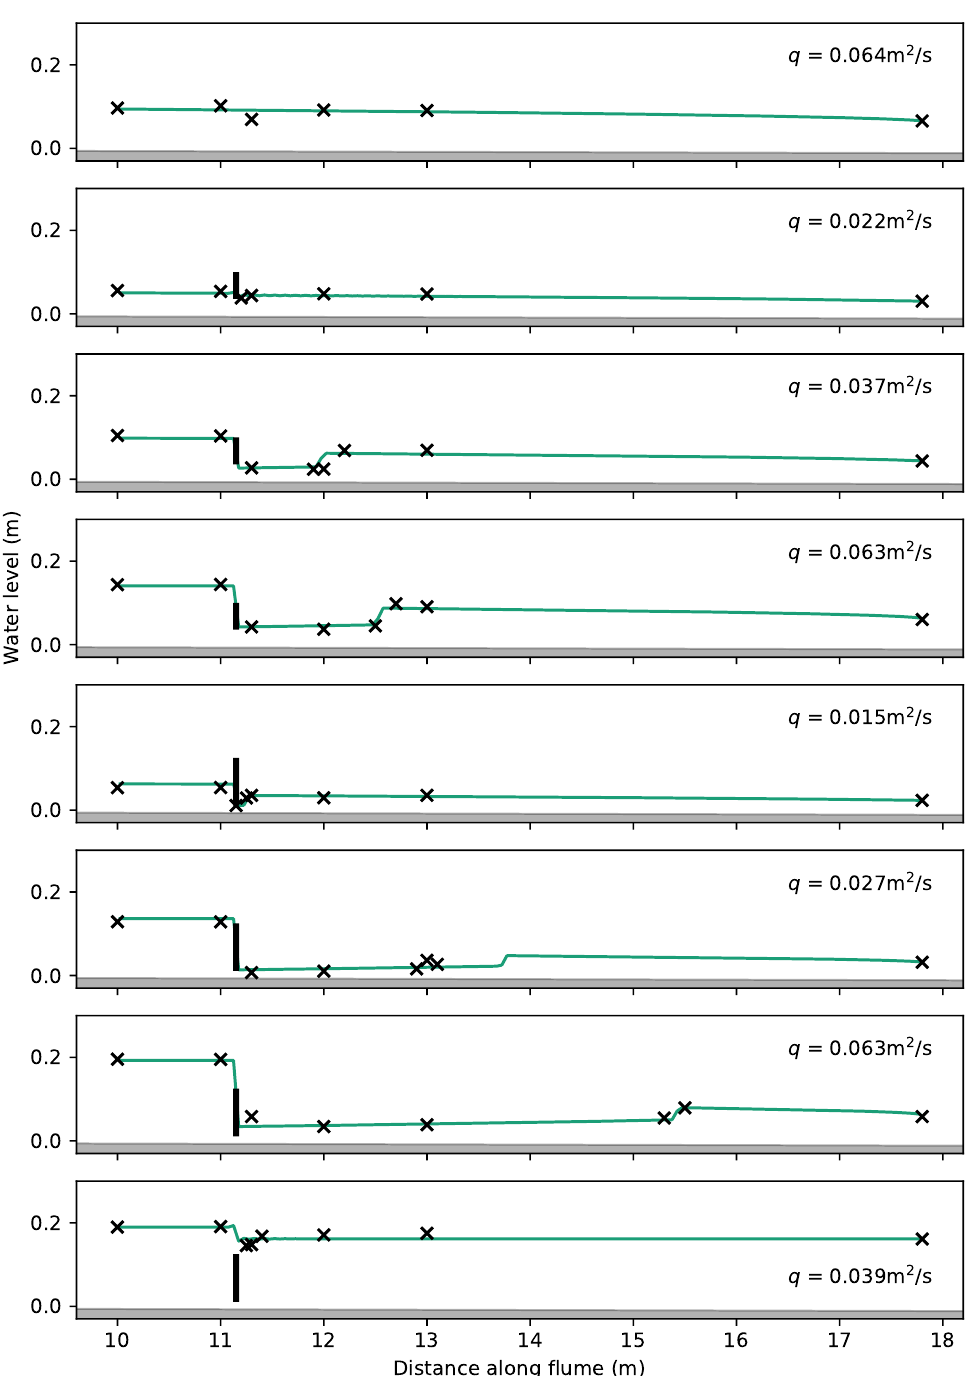
Figure 10. Numerical solutions (green lines) and observations (black crosses) for eight representative steady-state experiments in the flume. Note that the weir overflow is squeezed into the leaky barrier cell interface, so it is modelled even though it is not